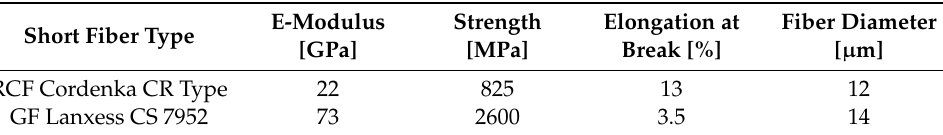
Table 1. Mechanical properties and diameter of RCF and